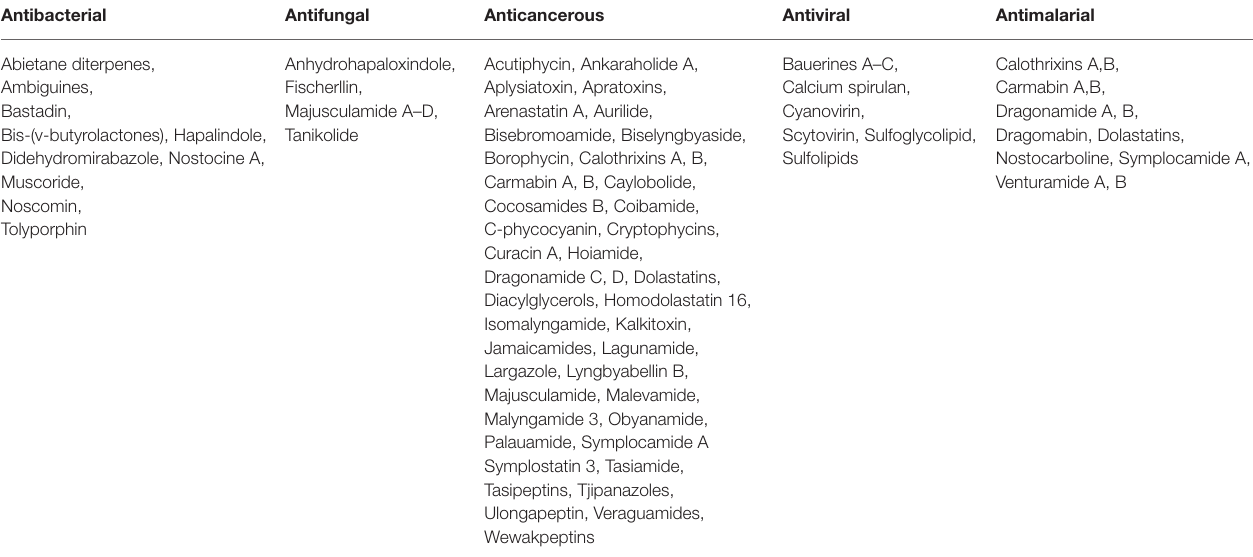
TABLE 2 | Cyanobacterial metabolites of pharmacological and biotechnological importance (Source: Rajneesh et al., 2017).